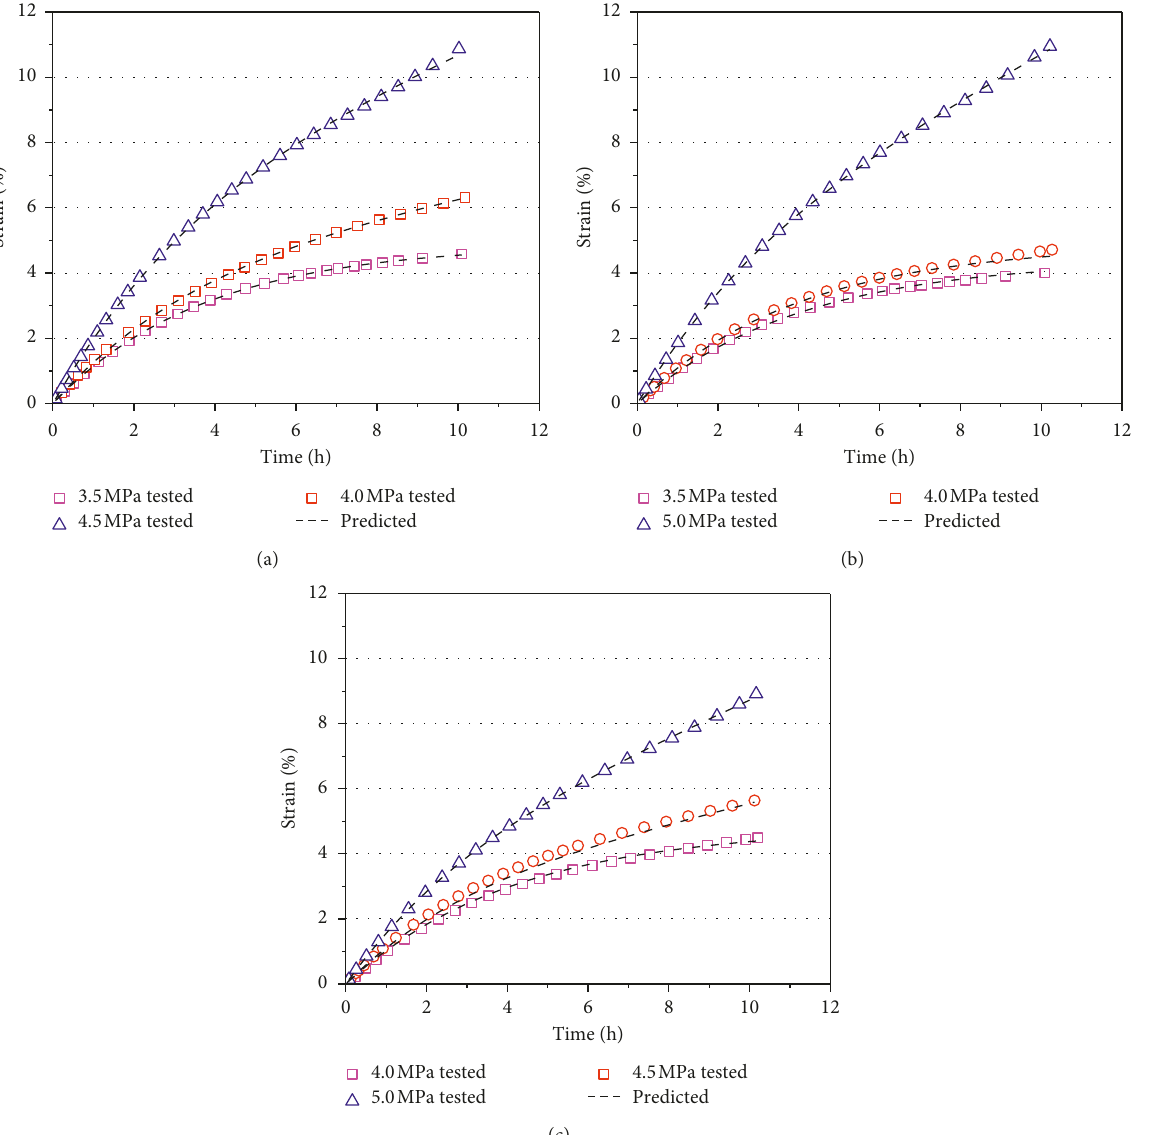
� 8MPa): (a) 3d, (b) 7d, and (c) 1